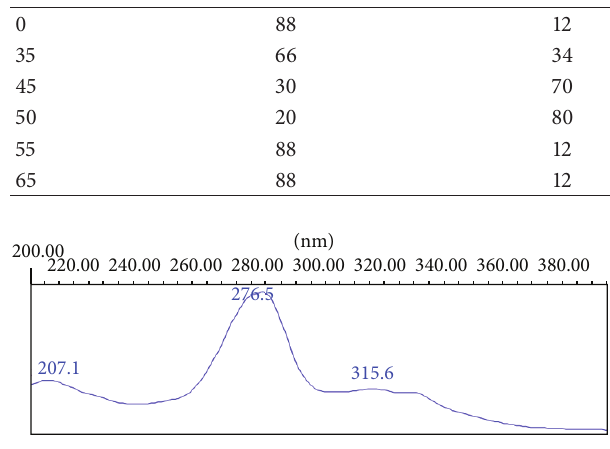
Figure 2: Spectra of EFX.